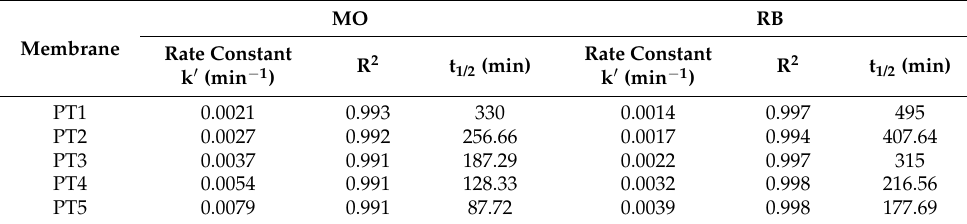
Table 4. The apparent first-order rate constant (k (cid:48) ) and half-life time of MO and RB degradation by plain and modified PVDF